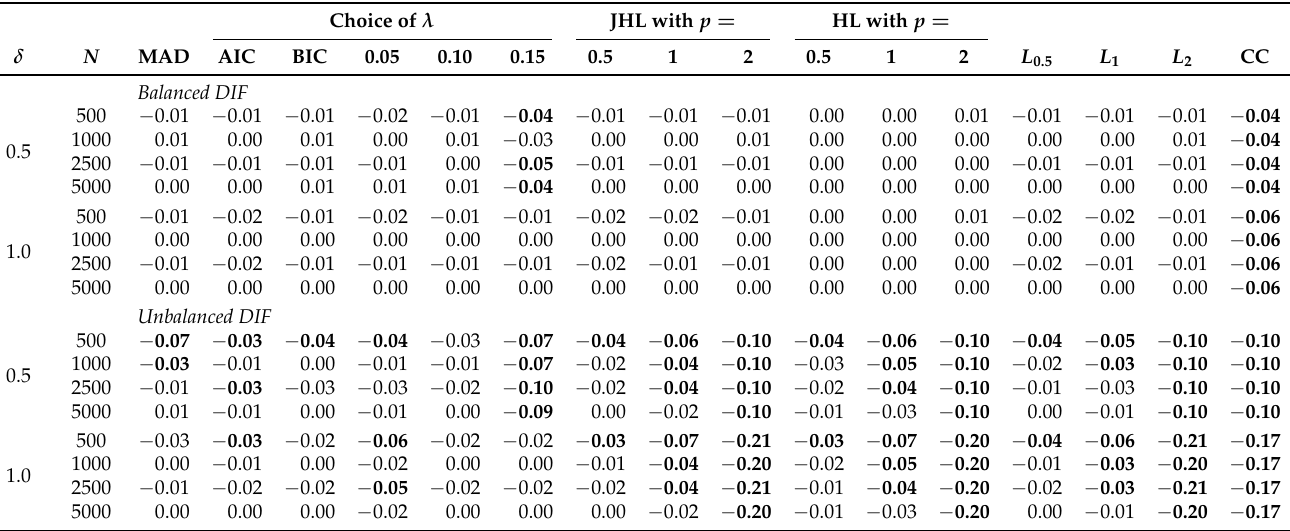
Table 4. Simulation Study 2: Bias of estimated group means for balanced and unbalanced DIF effects as a function of the size of DIF effects δ and sample size N . Choice of λ JHL with p =